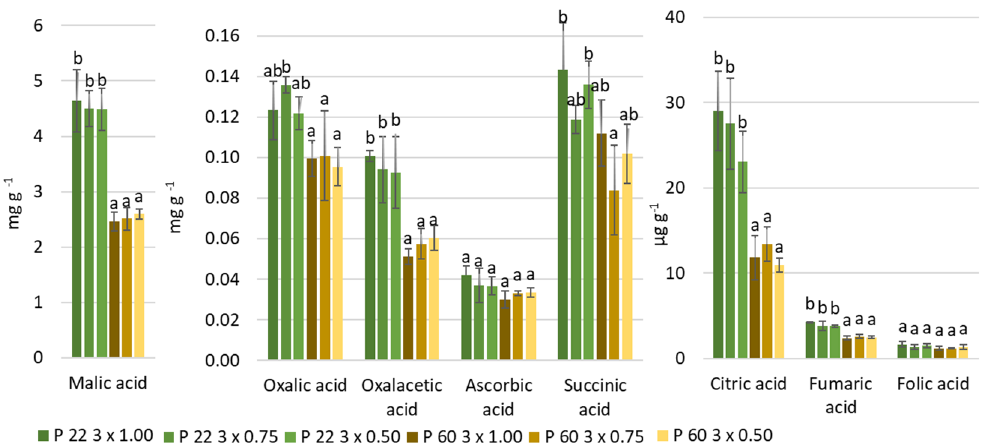
Figure 2. The effect of distances and rootstock on organic acids in apple fruits. The mean value (n = 3 × 3 = 9) ± standard deviation is presented. The data were processed using two-way analysis of variance (ANOVA), the Tukey (HSD) test at the confidence level p = 0.05. The different letters in blocks indicate significant differences.